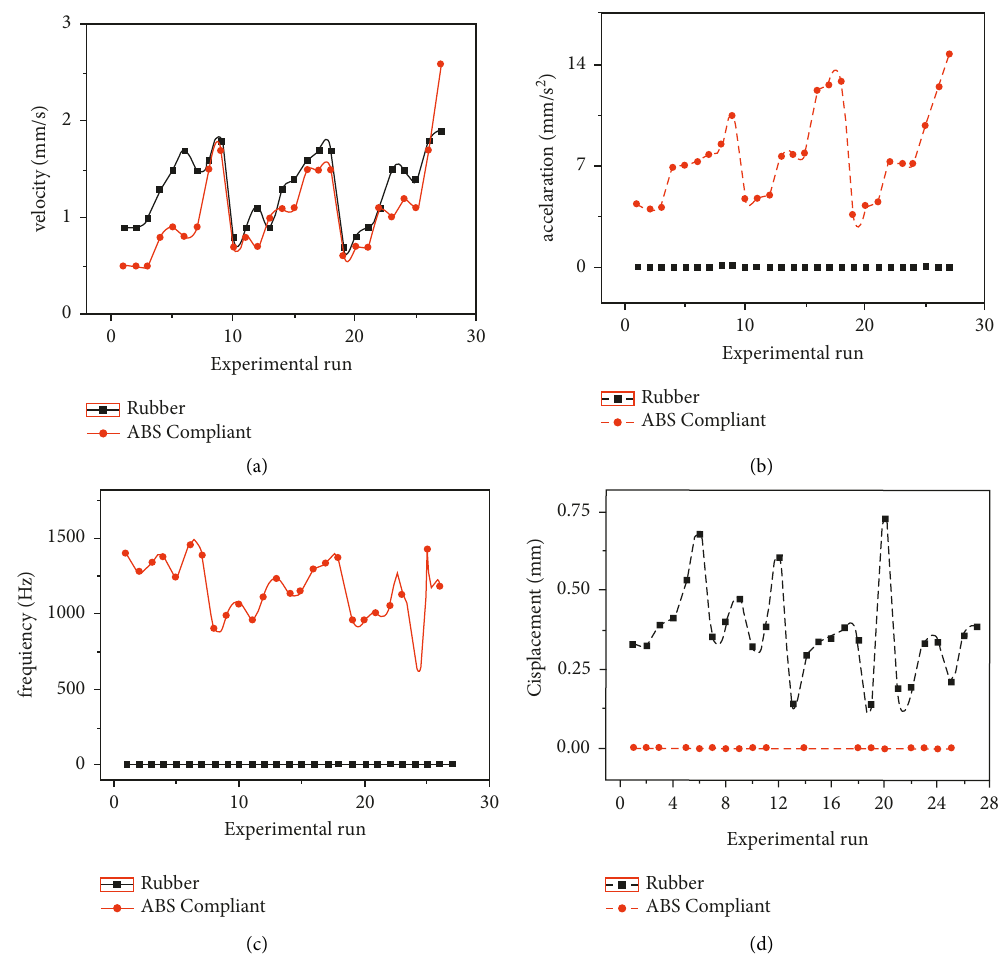
Figure 6: Vibration parameter responses for each experimental run—(a) velocity, (b) acceleration, (c) frequency, and (d) displacement.